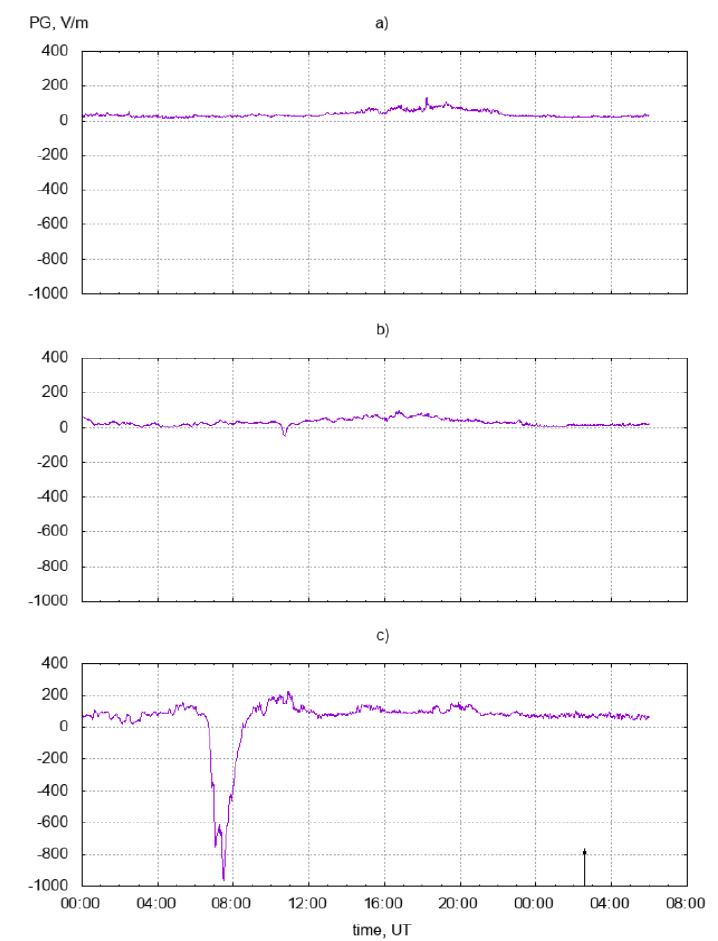
Figure 1. Typical diurnal PG variations on days with fair weather conditions without anomalies ( a ), days with precipitation ( b ), and days with fair weather conditions, but with anomalous PG behavior ( c ). The arrow indicates the time of an earthquake that occurred on 24 September 1997, K =